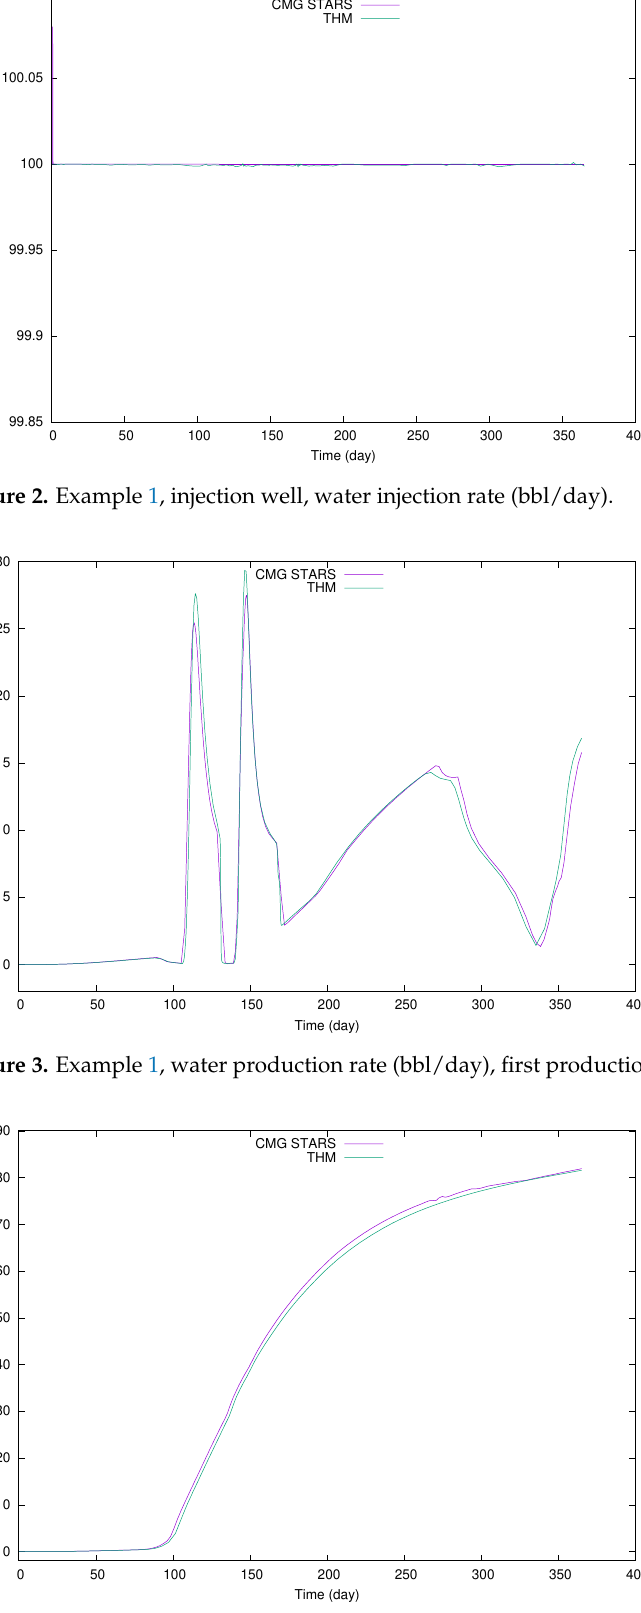
Figure 4. Example 1, water production rate (bbl/day), second production